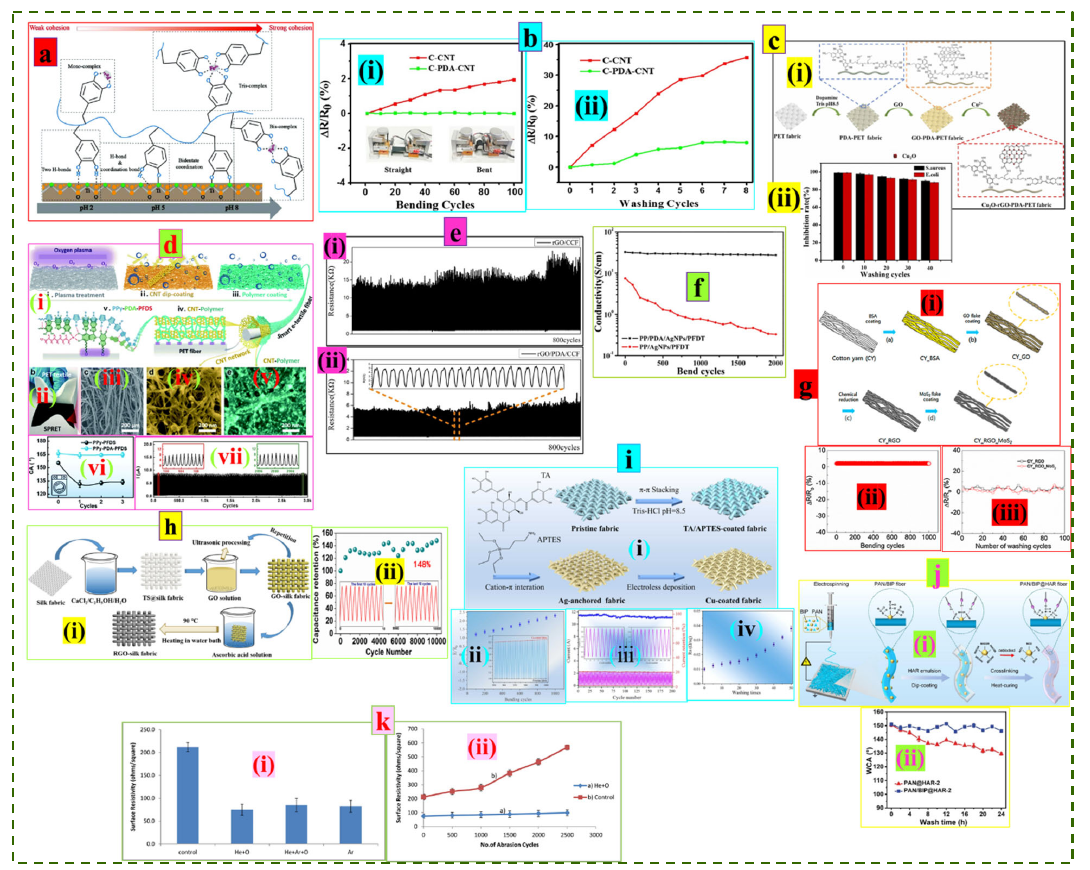
Figure 7. Different surface modification strategies. ( a ) pH ‐ dependent chemistry and adhesion mech ‐